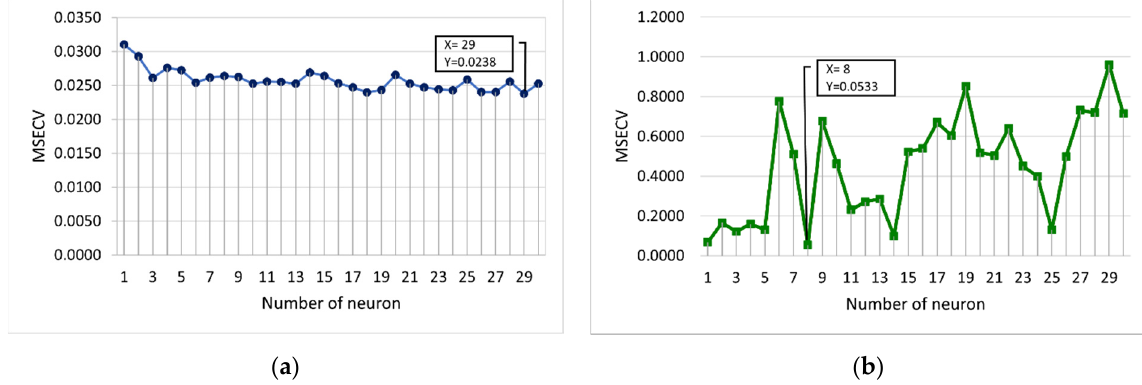
Figure 5. MSECV with a varying number of neurons for ( a ) FFNN-lm and ( b ) FFNN-gdm. Figures 6 and 7 present the MSECV with varying values of learning rate and momen- tum, respectively. In this case, both the learning rate and momentum were trained with values set at 0.1 to 1, with 10 runs required for each parameter. As depicted in Figure 6a, it was found that the learning rates of 0.3 (MSECV = 0.0238), 0.5 (MSECV = 0.0239), and 0.7 (MSECV = 0.0232) would probably produce good results for FFNN-lm. However, the learning rates for conventional-based FFNN were obtained at 0.7 and 0.2 for lm and gdm, respectively, which gave the lowest MSECV of 0.0232 and 0.3403 for lm and gdm, respec- tively.